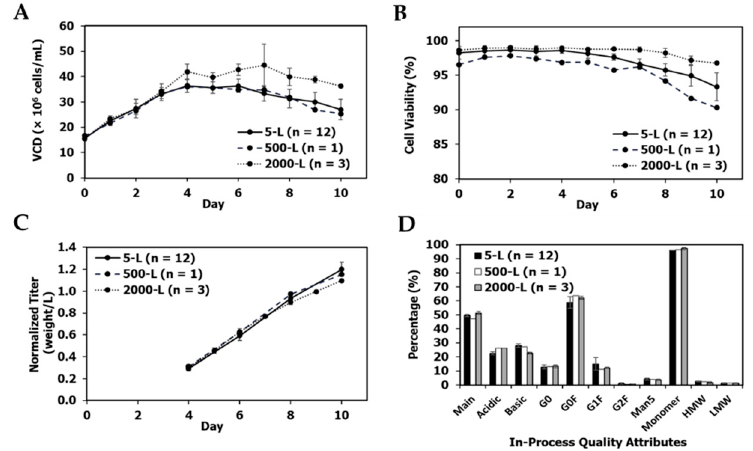
Figure 11. mAb3 re-clone production 500-L and 5-L satellite bioreactor culture performance, and quality attributes. ( A ) Production bioreactor VCD, ( B ) production viability, ( C ) normalized titer relative to 2000-L day 10 titer, ( D ) in-process quality attribute profiles on day 14 at harvest. Only 5-L and 2000-L values are reported as average ± standard deviation (n ≥ 3).